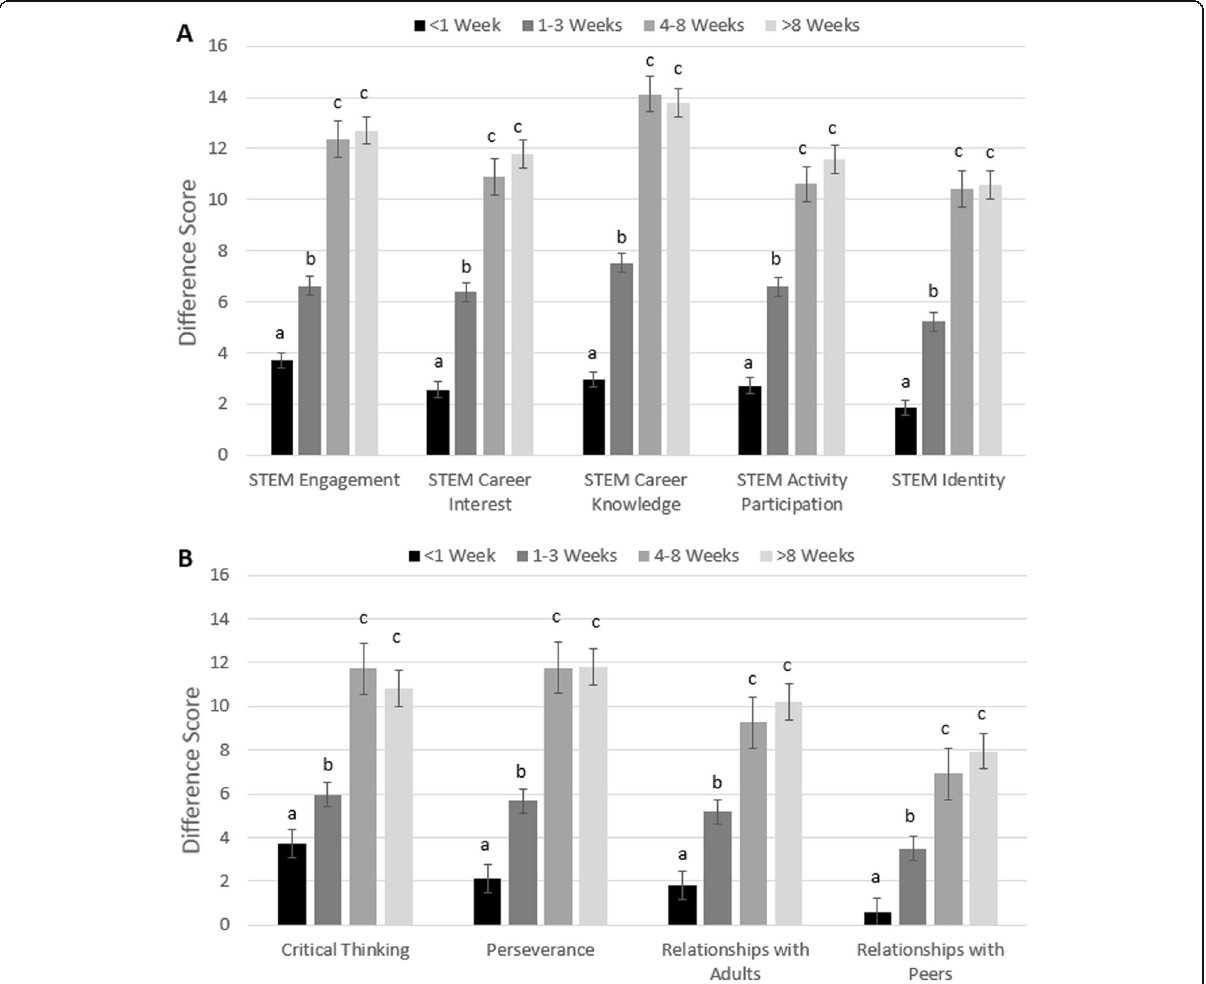
Fig. 1 Mean (± SD) retrospective pretest-posttest difference scores for youth self-reported a STEM attitudes and b SEL/twenty-first-century skills by STEM program duration (using the CIS-S). Means with different letters within each scale are significantly different ( p <